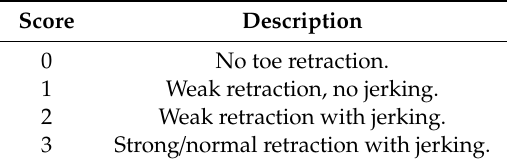
Table 3. Scoring of the toe pinch withdrawal test in spinal cord injury (SCI)